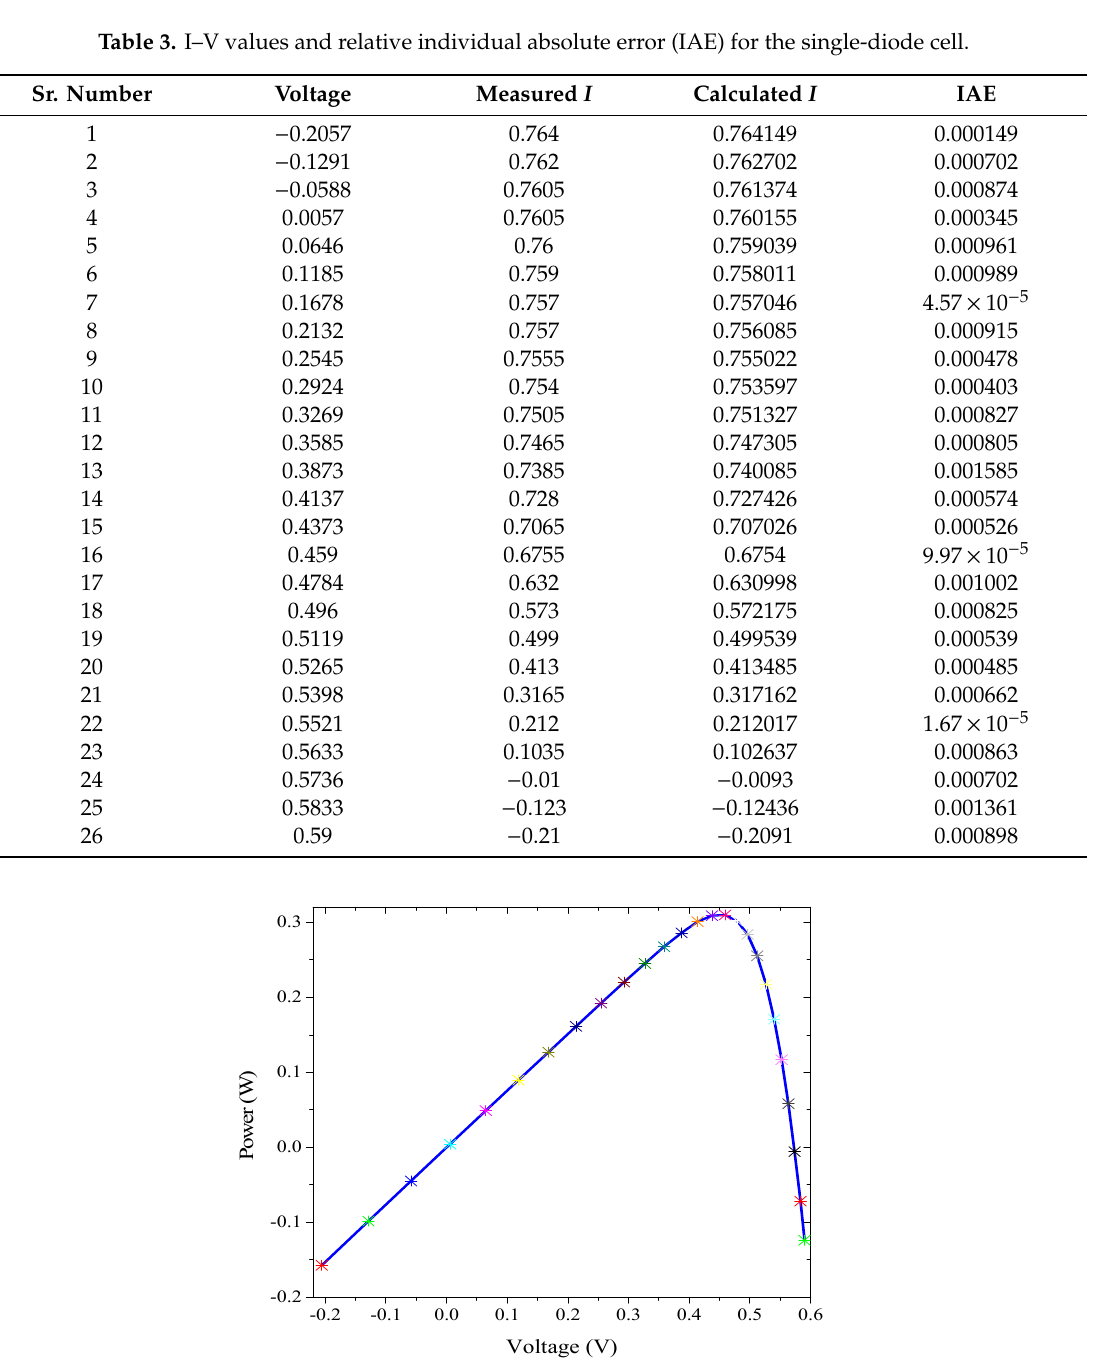
Figure 7. P–V curve obtained from the calculated current for the single-diode cell. Table 4. Results for the double-diode cell.